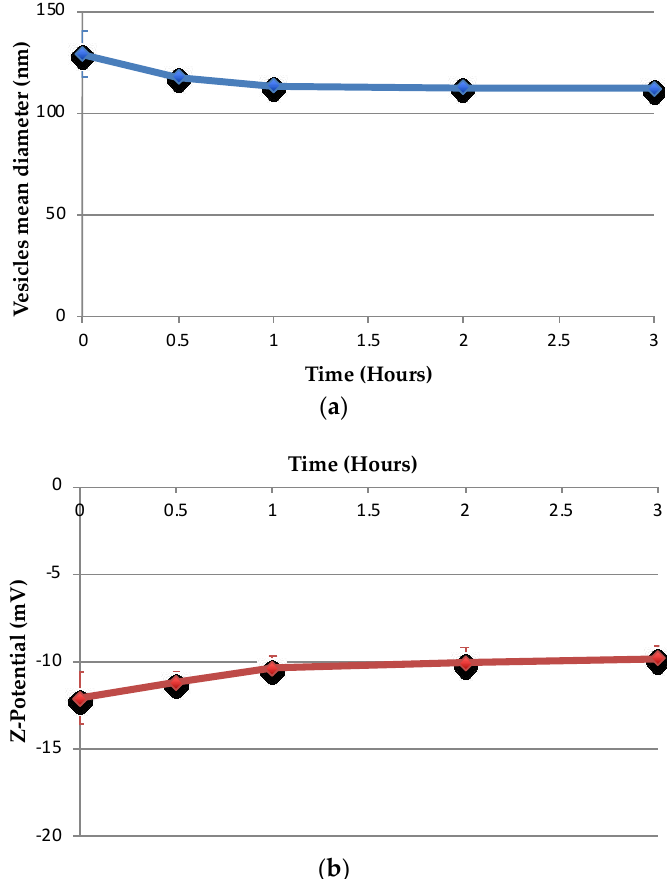
Figure 8. Changes of Nio–aCSF mixture in ( a ) hydrodynamic diameter and ( b ) ζ-potential over a 3 h period. Values represent the mean ± standard deviation of n = 3 sample measurements.